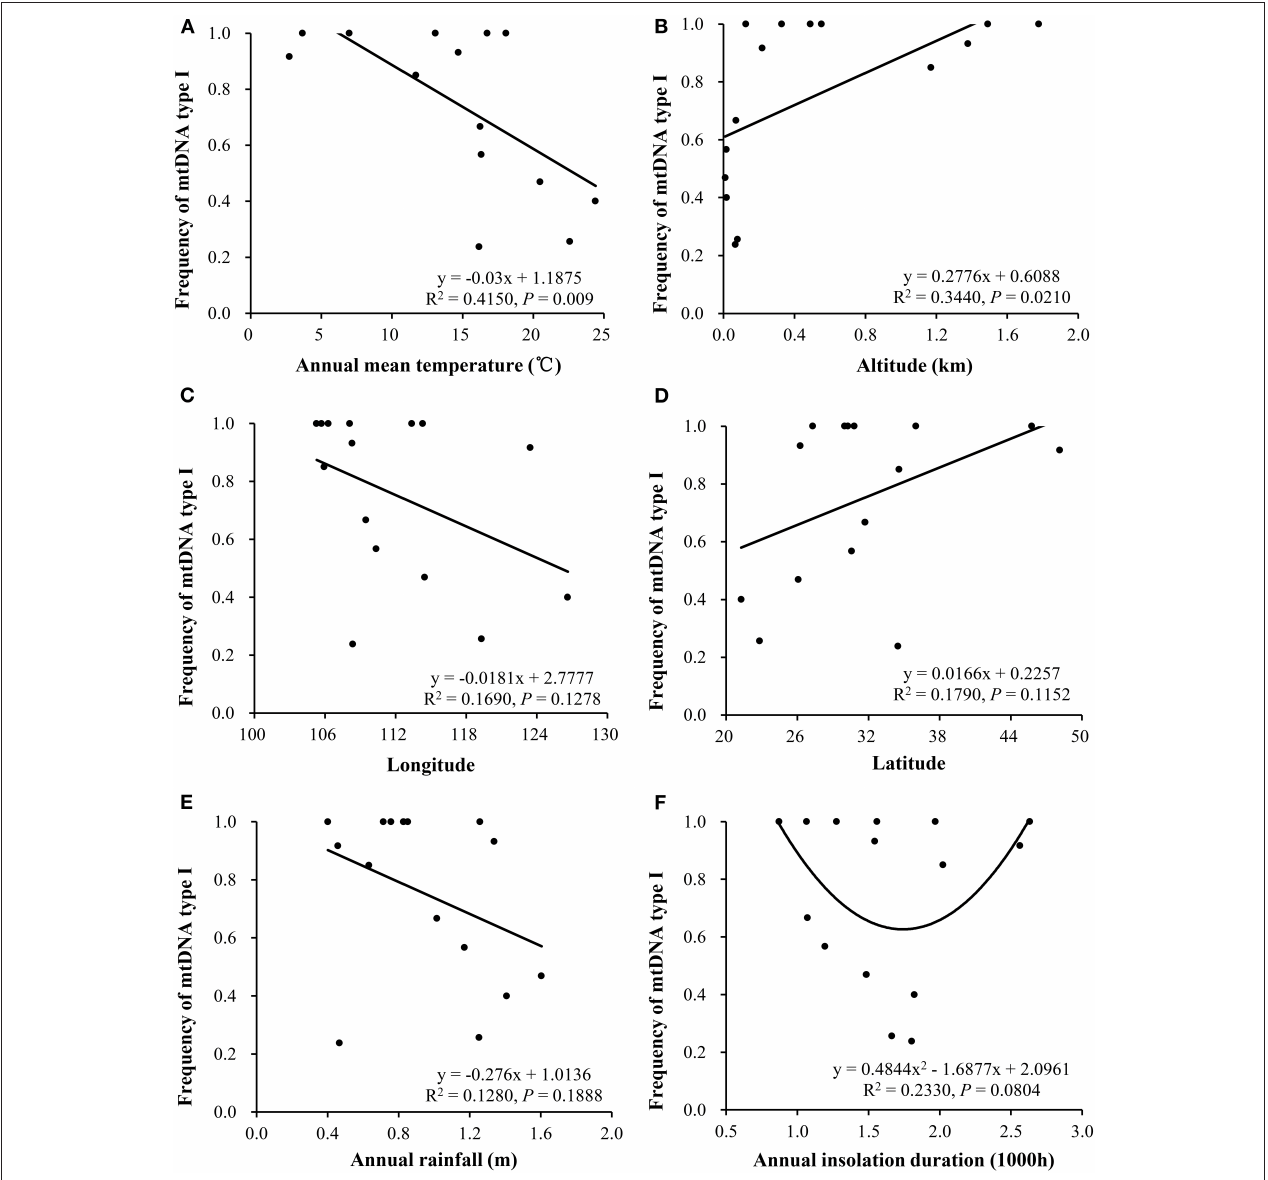
FIGURE 3 | Associations of mitochondrial haplotype I with climatic conditions and tick in the P. infestans populations collected from China: (A) Annual means temperature, (B) altitude, (C) longitude, (D) latitude, (E) annual rainfall, and (F)